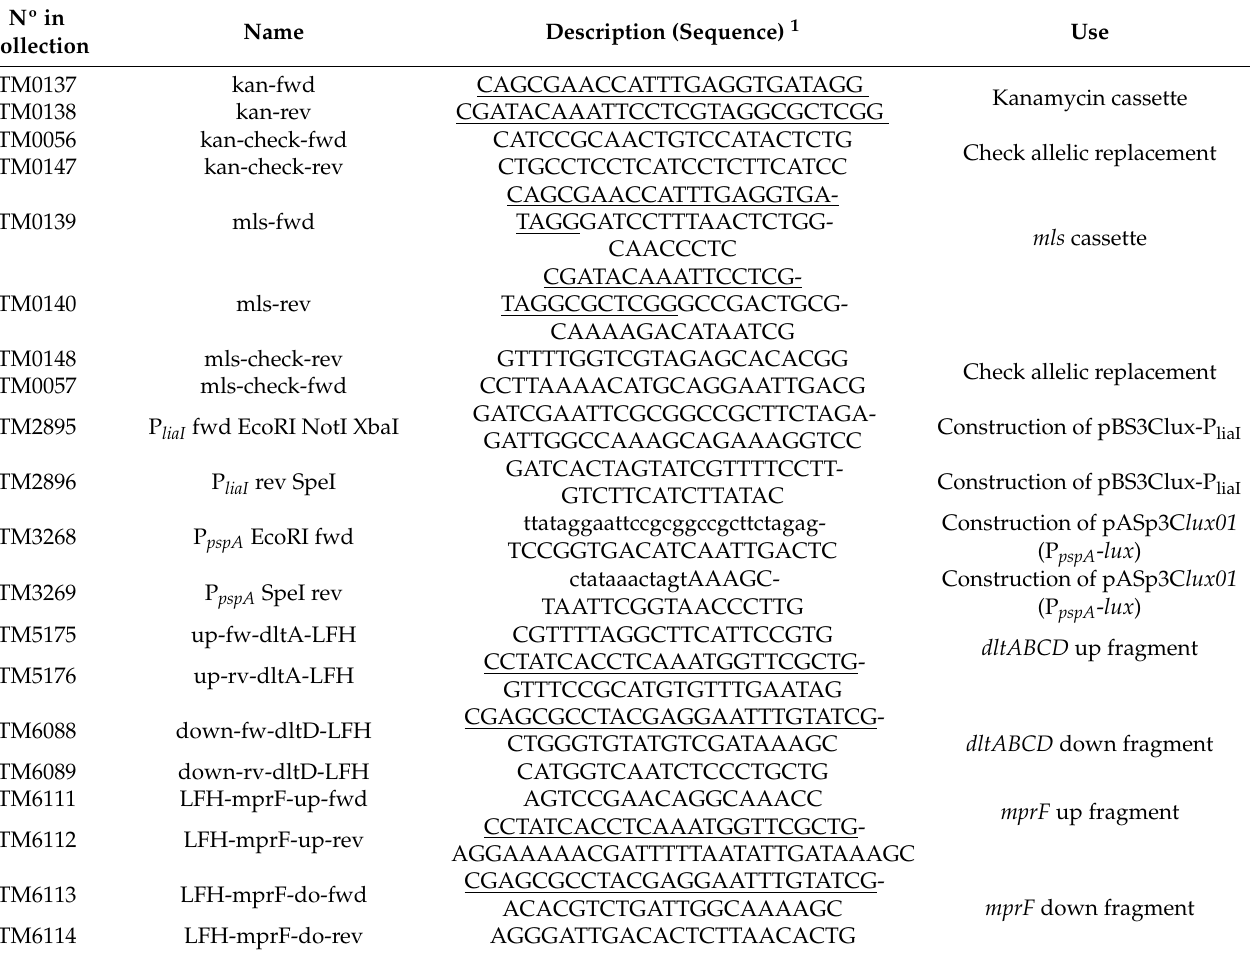
Table 2. Oligonucleotides used in this study for gene knockout via